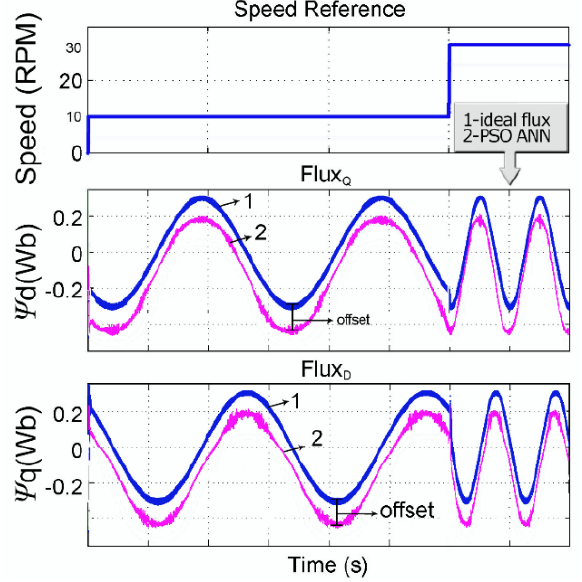
Figure 13. Comparison between estimated (pink) and ideal flux (blue). Figure 14. Comparison of fluxes in the q - and d -axes.